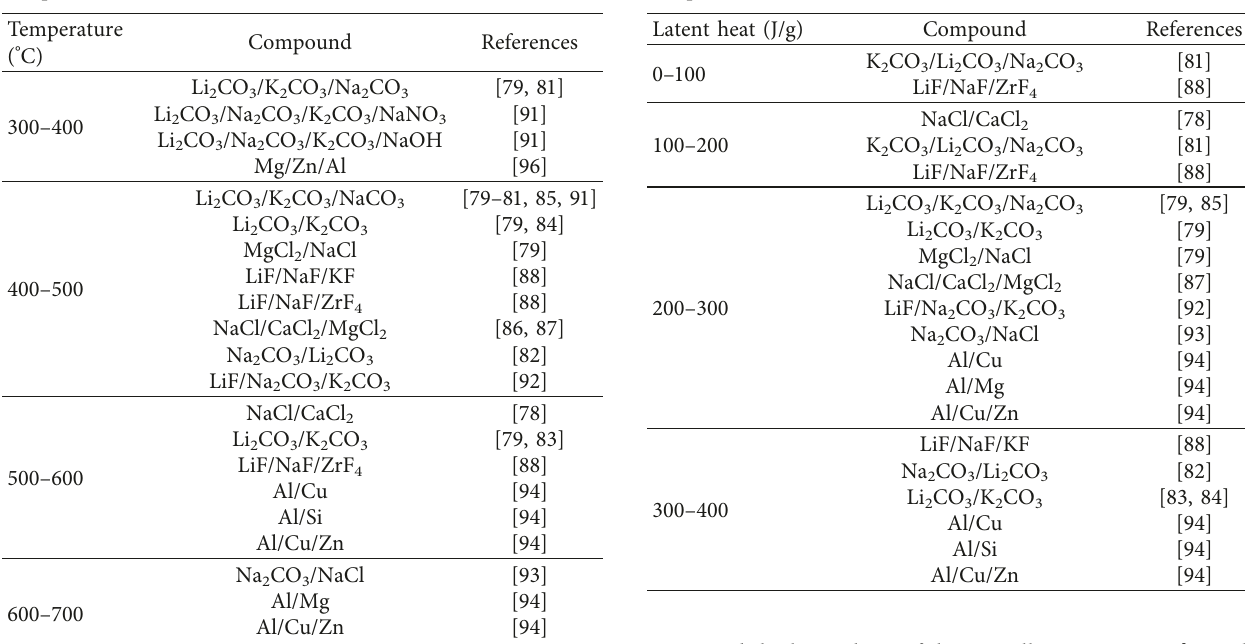
Table 5: The melting point of high-temperature inorganic eutectic composites.